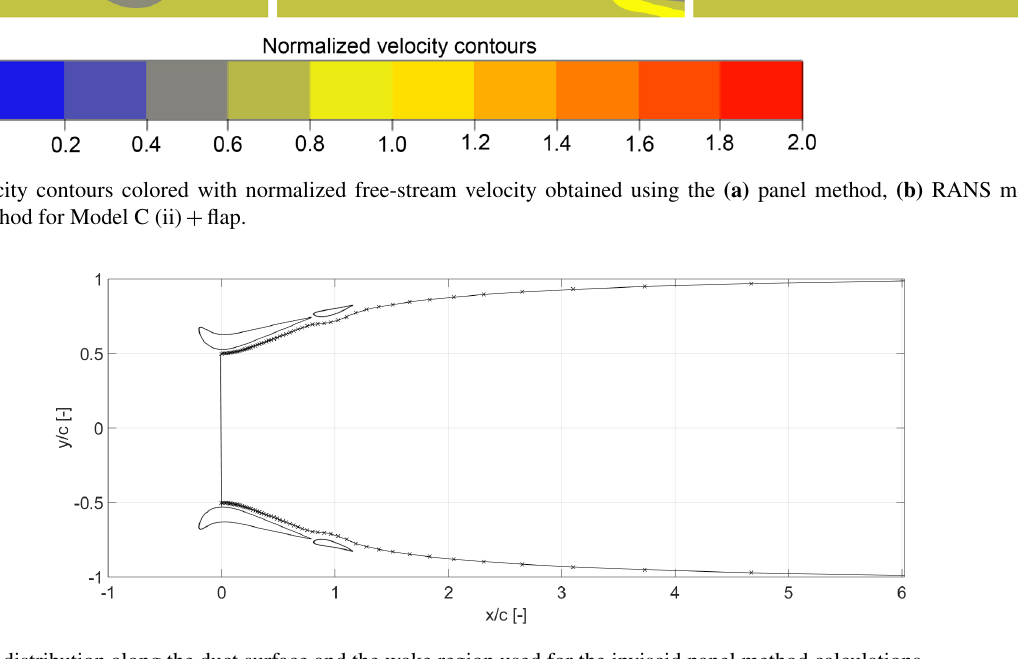
Figure 5. Panel distribution along the duct surface and the wake region used for the inviscid panel method calculations.